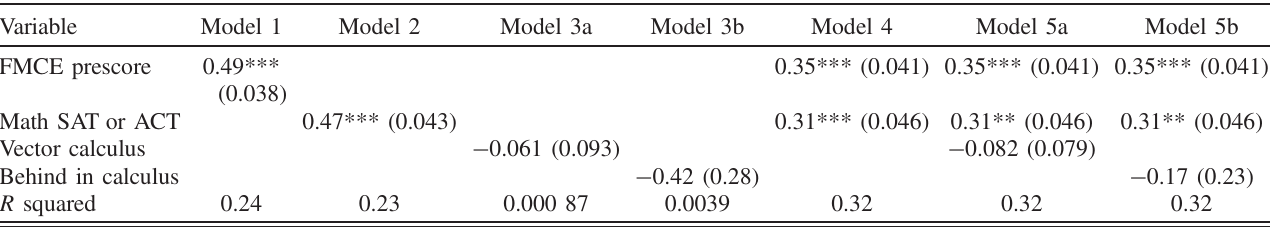
TABLE II. Regression models predicting physics 1 final exam score. *** p < 0 . 001 , ** p < 0 . 01 , * p < 0 . 05 . Numbers in parentheses are the standard errors of the coefficients. All coefficients are in units of standard